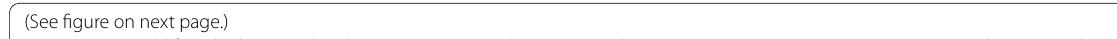
Fig. 9 19 year old female diagnosed with MS 7 years ago with EDSS (4) and cognitive impairment. ( A ) 3D FLAIR images: showing multiple foci and patchy areas of high signal intensity implicating the peri ventricular and juxta cortical white matter being perpendicular on the ventricular ystem and giving the characteristic dowsn finger appearance. ( B ) 3DT1WI showing multiple foci and patchy areas of low signal intensity implicating the peri ventricular and juxta cortical white matter being perpendicular on the ventricular system and giving the characteristic Dowsn finger appearance. ( C ) MR volumetry images